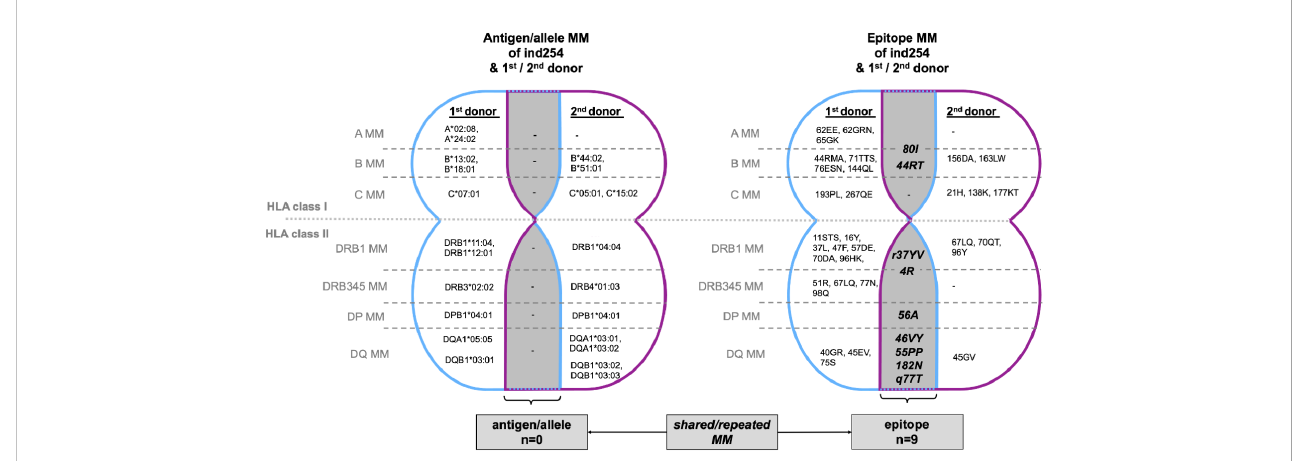
FIGURE 3 Case/Outlook: Illustraion of MM between KT recipient (ind254) and his 1 st (living) and 2 nd (postmortem) donor. The overlapping areas (gray) highlight those MM shared by the 1 st and 2 nd donors, i.e., MM that recur with the second transplantation. No repeated MM are observable at the antigen/allele level, but 9 MM at epitope level (HLA class I n=2, HLA class 2, n=7). Immunologically the immunization against the 2 nd donor, e.g., towards B*51:01 (epitopes 80I and 82LR) react against the A*24:02 of the primary donor. The comprehensive HLA typing of ind254 and both donors is deciphered in Supplementary Table ST3. HLA, human leukocyte antigen; MM,